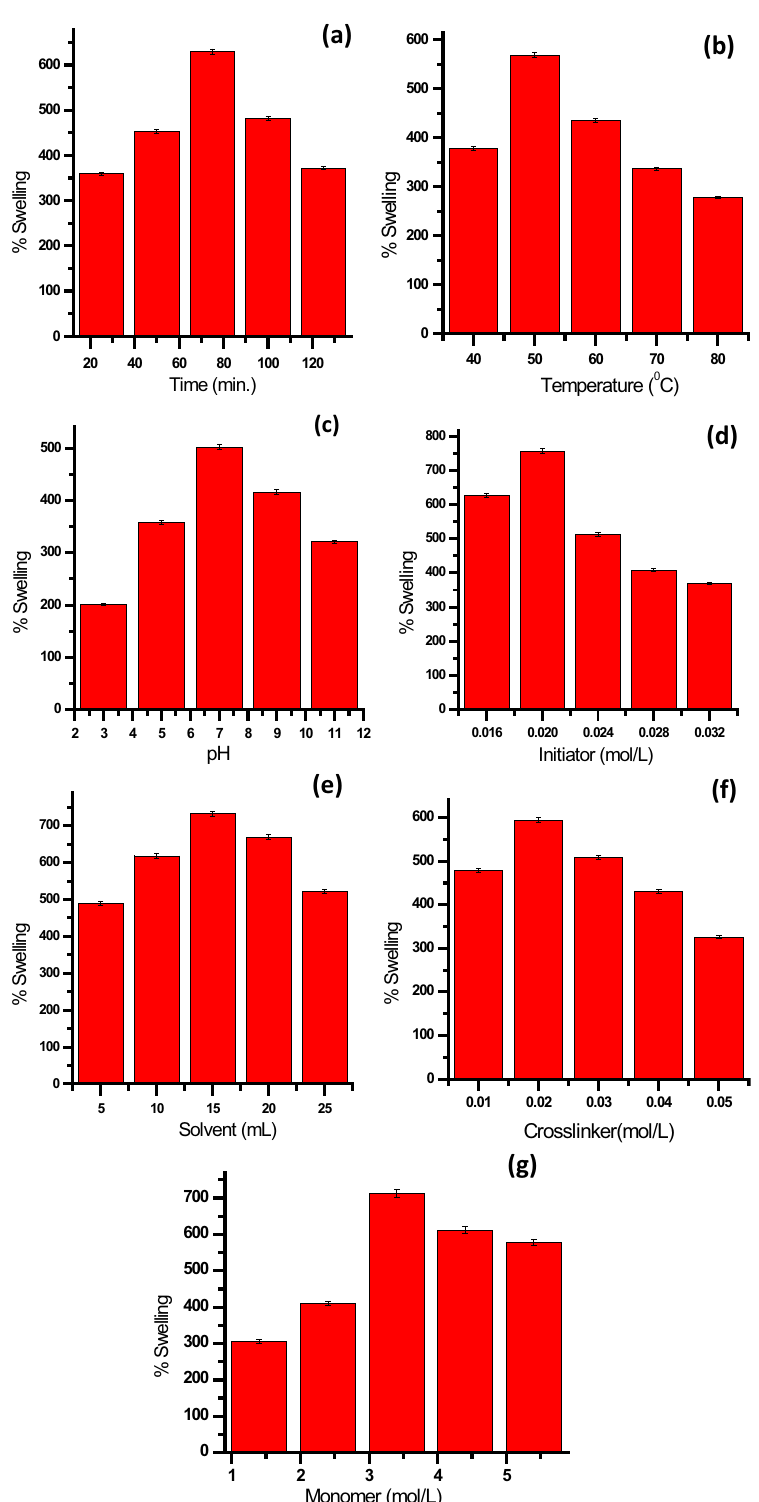
Fig. 5 a–g Impact of a time; b temperature; c pH; d initiator concentration; e solvent; f cross-linker concentration; and g monomer concentration on Ps of Av-cl-poly